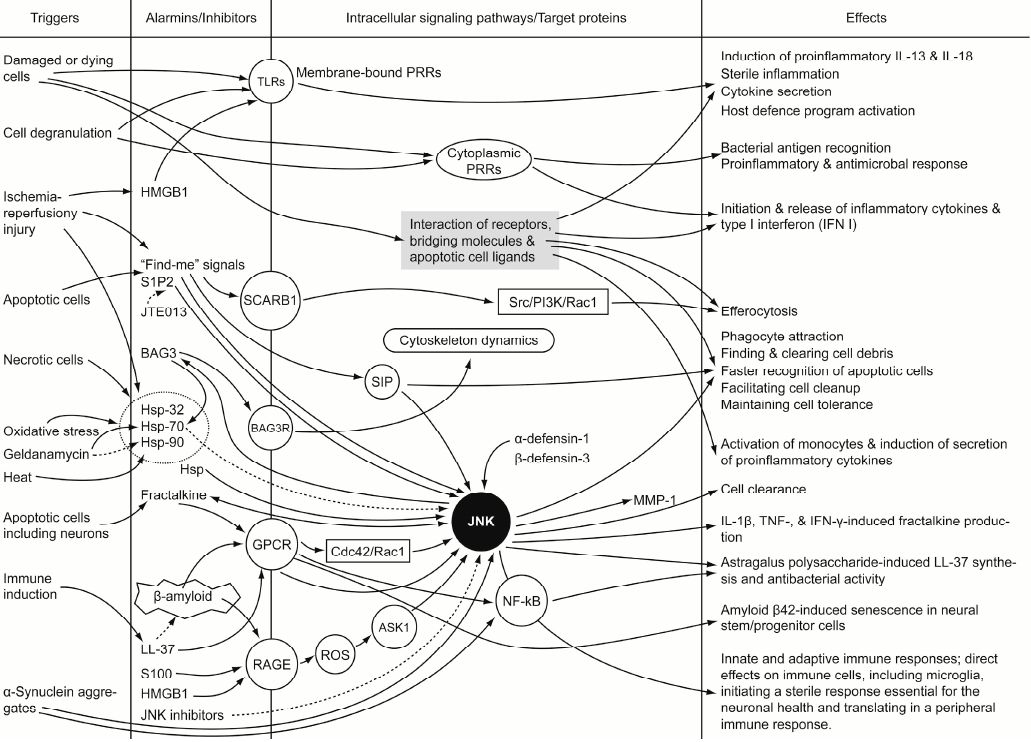
Figure 1. Schematic representation of alarmin signaling and interplay between the alarmin and JNK-signaling pathways. Solid lines indicate activation/induction processes; dashed lines indicate downregulation mechanisms. Table 1. The origins, receptors and potential biological effects of alarmins in neuroinflammation Alarmin